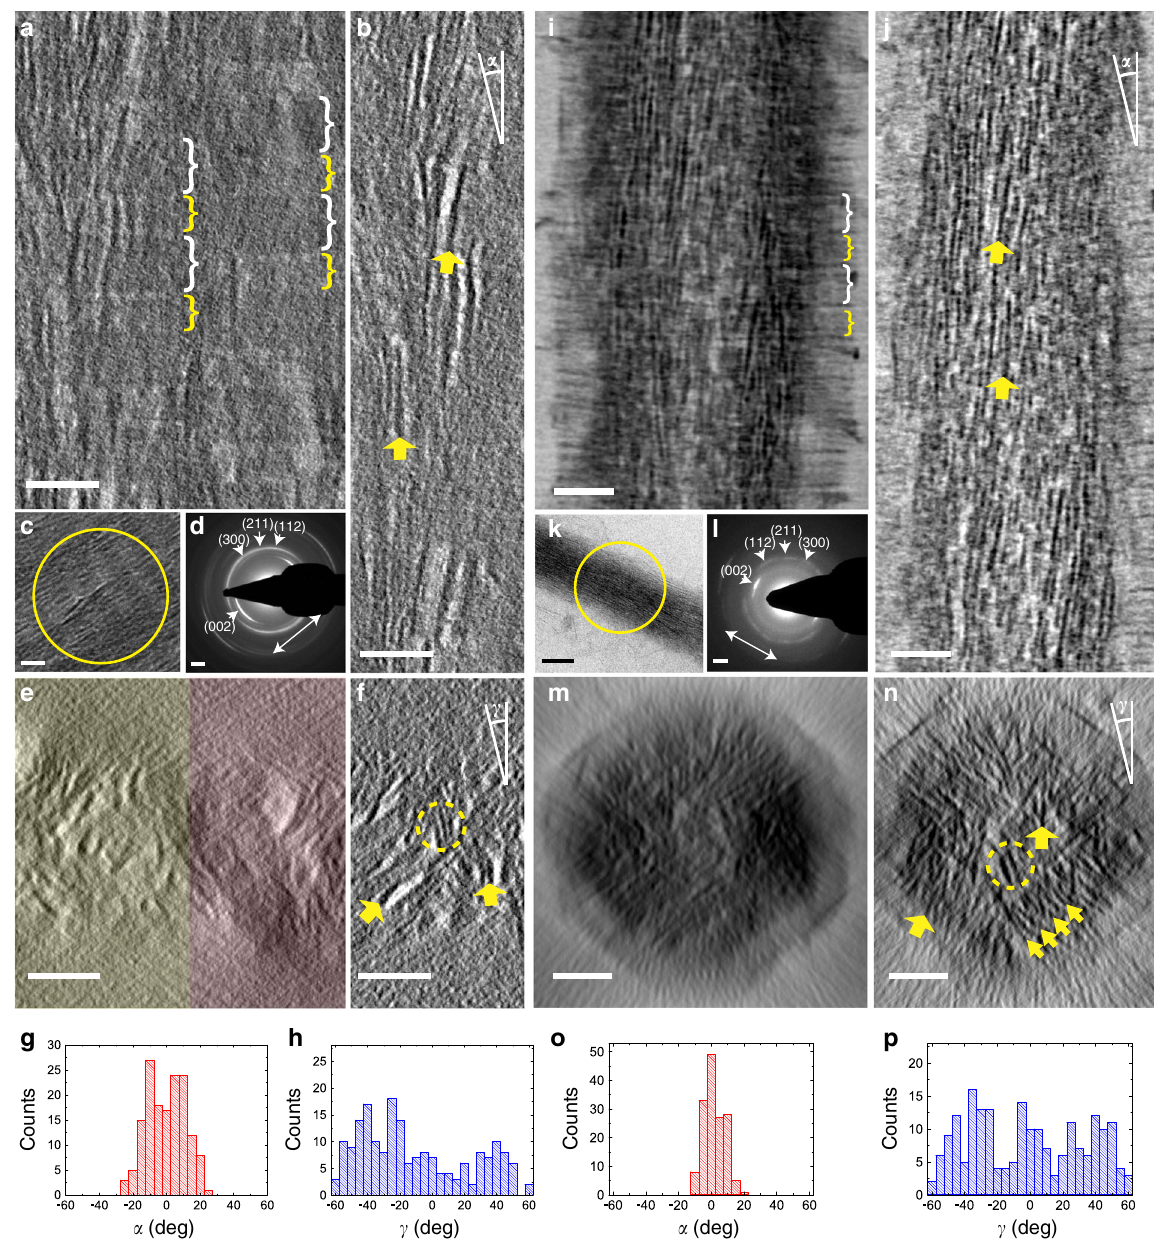
Fig. 2 Electron tomography of in vitro and in vivo mineralized collagen fi brils. a – h Electron tomography of a human bone lamella. a 2D projection of 70 tomographic reconstruction y -slices showing two adjacent mineralized collagen fi brils. b Tomographic reconstruction y -slice of one single fi bril averaged from fi ve adjacent slices. c TEM image of two parallel fi brils. d LDSAED pattern of the circled area in c . e 2D projection of 400 cross-section tomographic reconstruction z -slices showing two adjacent fi brils, as highlighted in yellow and red, respectively. f Tomographic reconstruction z -slice of one single fi bril averaged from 10 adjacent slices. g , h Longitudinal and lateral angular distributions ( α and γ , as indicated in b and f , respectively) of HAp platelets in the fi bril. i – p Cryogenic electron tomography of a type I collagen fi bril mineralized with HAp in the presence of pAsp and stained with uranyl acetate 38 . i 2D projection of 50 tomographic reconstruction y -slices showing one mineralized collagen fi bril. j Tomographic reconstruction y -slice of one single fi bril averaged from fi ve adjacent slices. k CryoTEM image of one single fi bril. l LDSAED pattern of the circled area in k . m 2D projection of 300 tomographic reconstruction z -slices of one single fi bril. n Tomographic reconstruction z -slice of one single fi bril averaged from 10 adjacent slices. o , p Longitudinal and lateral angular distributions of the platelets, respectively. The gap/overlap regions are highlighted in a and i by white/yellow brackets, respectively. Gap regions in a are darker than overlap regions due to heavy metal staining (see Supplementary Fig. 1). Long axis of the fi brils are indicated by white arrows in d and l . The orientations of some HAp platelets are highlighted in b , f , j , and n by yellow arrows. Stacks of HAp platelets are highlighted in f and n by yellow circles, while a stack of ~10 HAp platelets is highlighted in n by an array of yellow arrows. ~150 crystals were measured that were at least 20 nm apart for b and j , and 100 nm apart for f and n . Scale bars: all panels 50 nm, except d and i 2 nm − 1